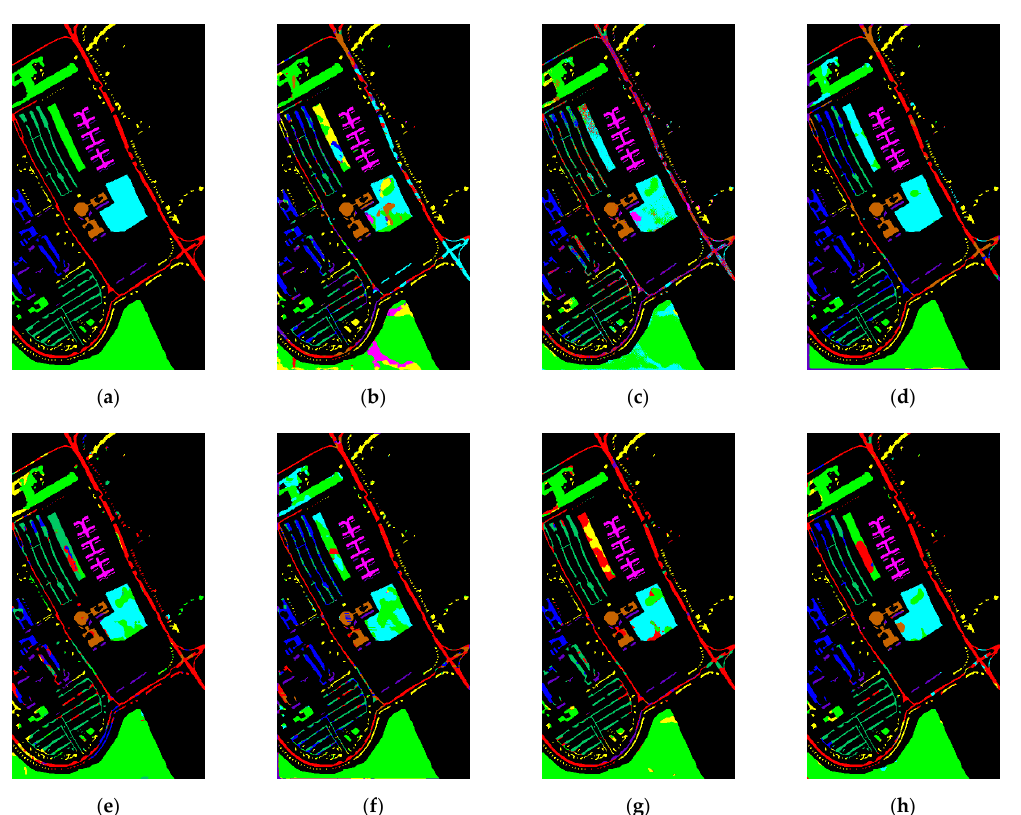
Figure 13. Classification maps for PU dataset. ( a ) Ground ‐ truth map; ( b ) 3D ‐ CNN; ( c ) HybridSN; ( d ) SSRN; ( e ) MCNN ‐ CP; ( f ) A 2 S 2 K ‐ ResNet; ( g ) Oct ‐ MCNN ‐ HS; ( h ) proposed method.